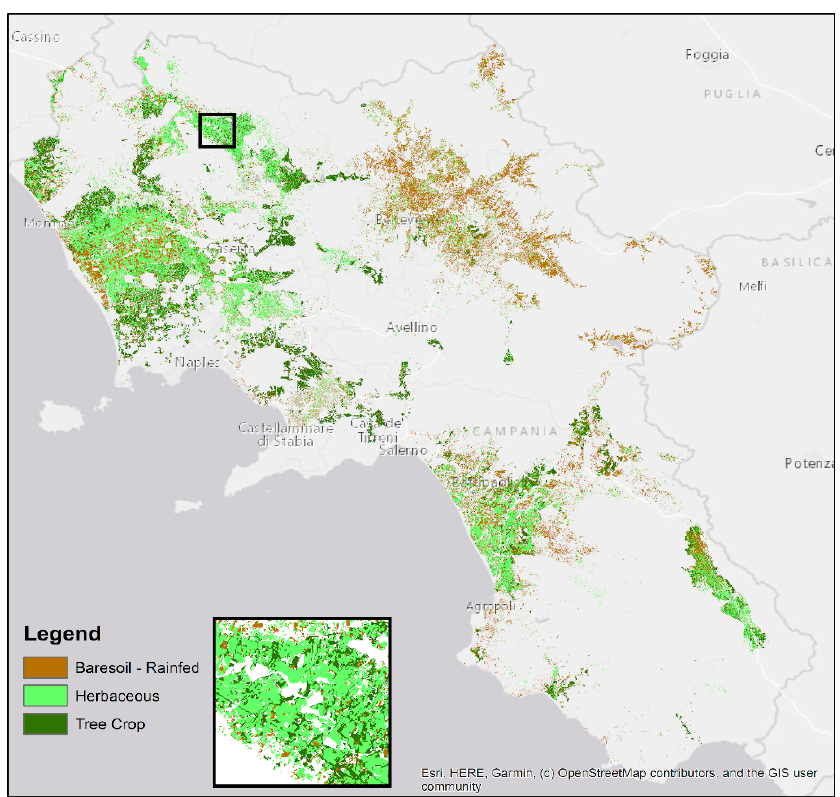
Figure 14. Classification map obtained over the study area in the Campania region (southern Italy) associated with the best model (75% of the labeled samples used for training). associated with the best model (75% of the labeled samples used for